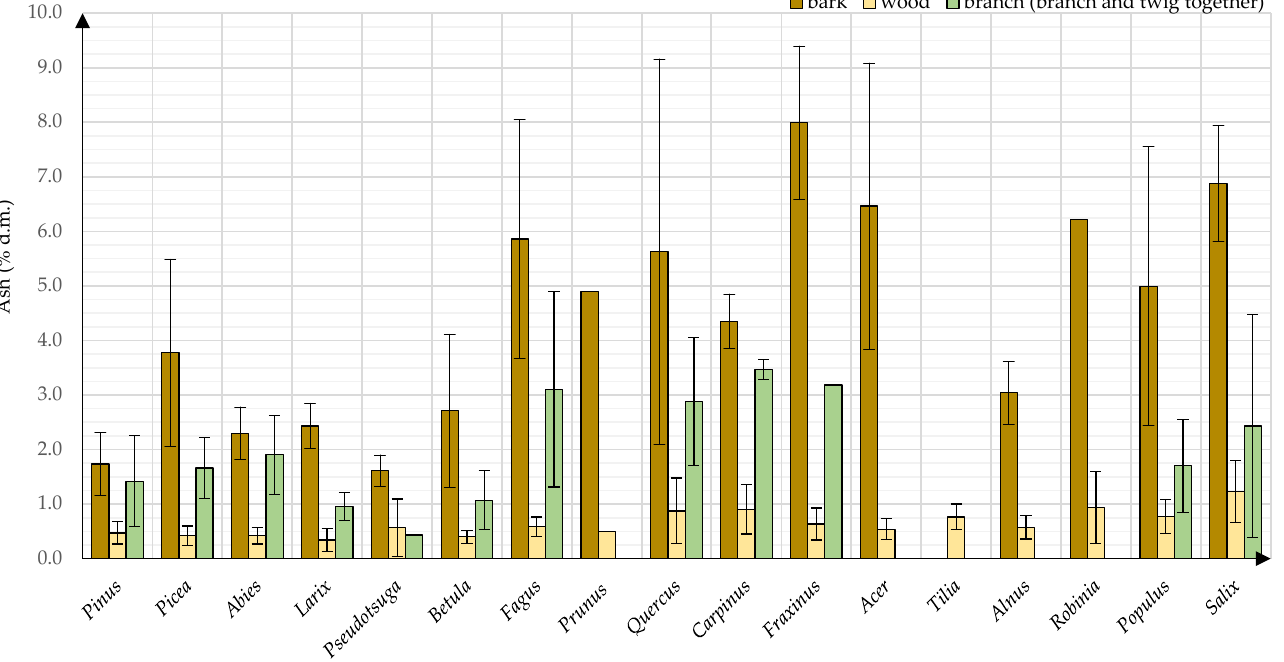
Figure 8. Average value and average deviation of the ash content of organs of particular systematic genera trees.